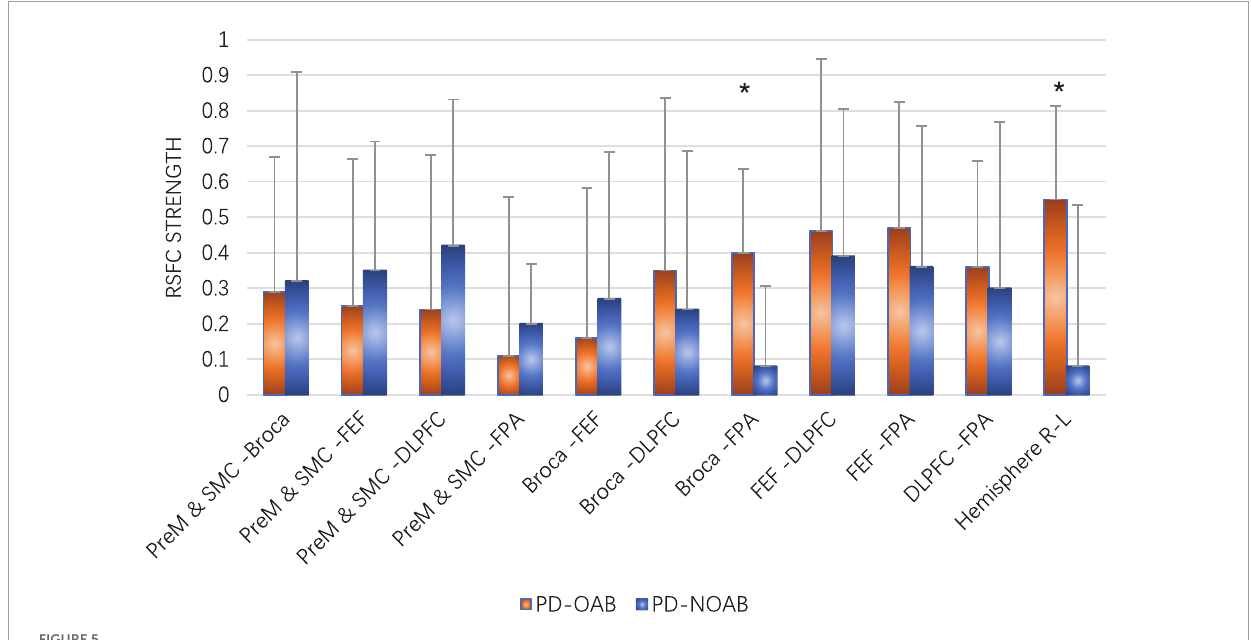
FIGURE5 Two-sample t -test of RSFC strength between the ROI and two hemispheres for the PD-OAB and PD-NOAB groups. * P <